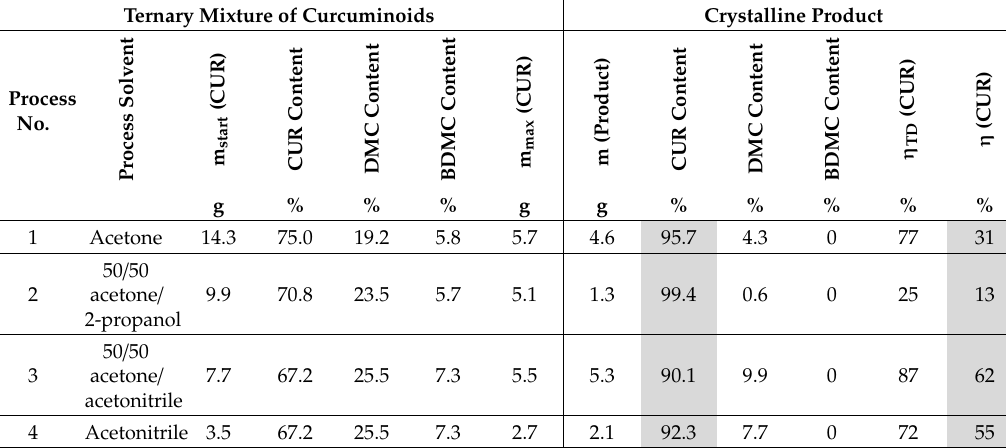
Table 6. Results of the four seeded cooling crystallization processes. Table columns containing the products purity and yield are highlighted in grey.